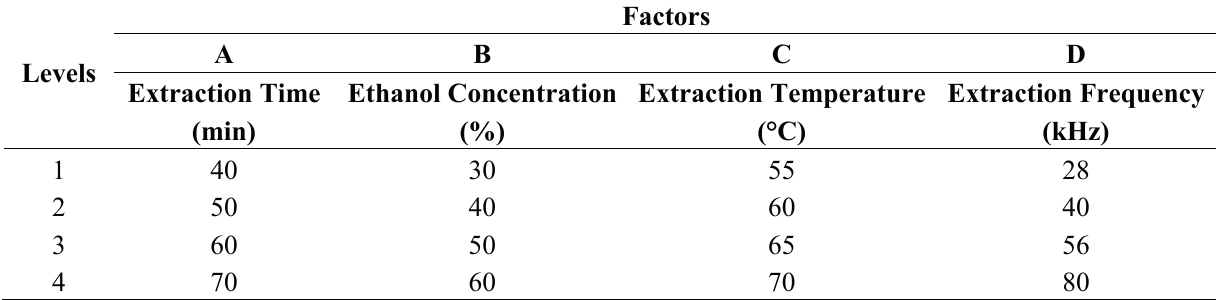
Table 1. Factors and levels of orthogonal experimental design.